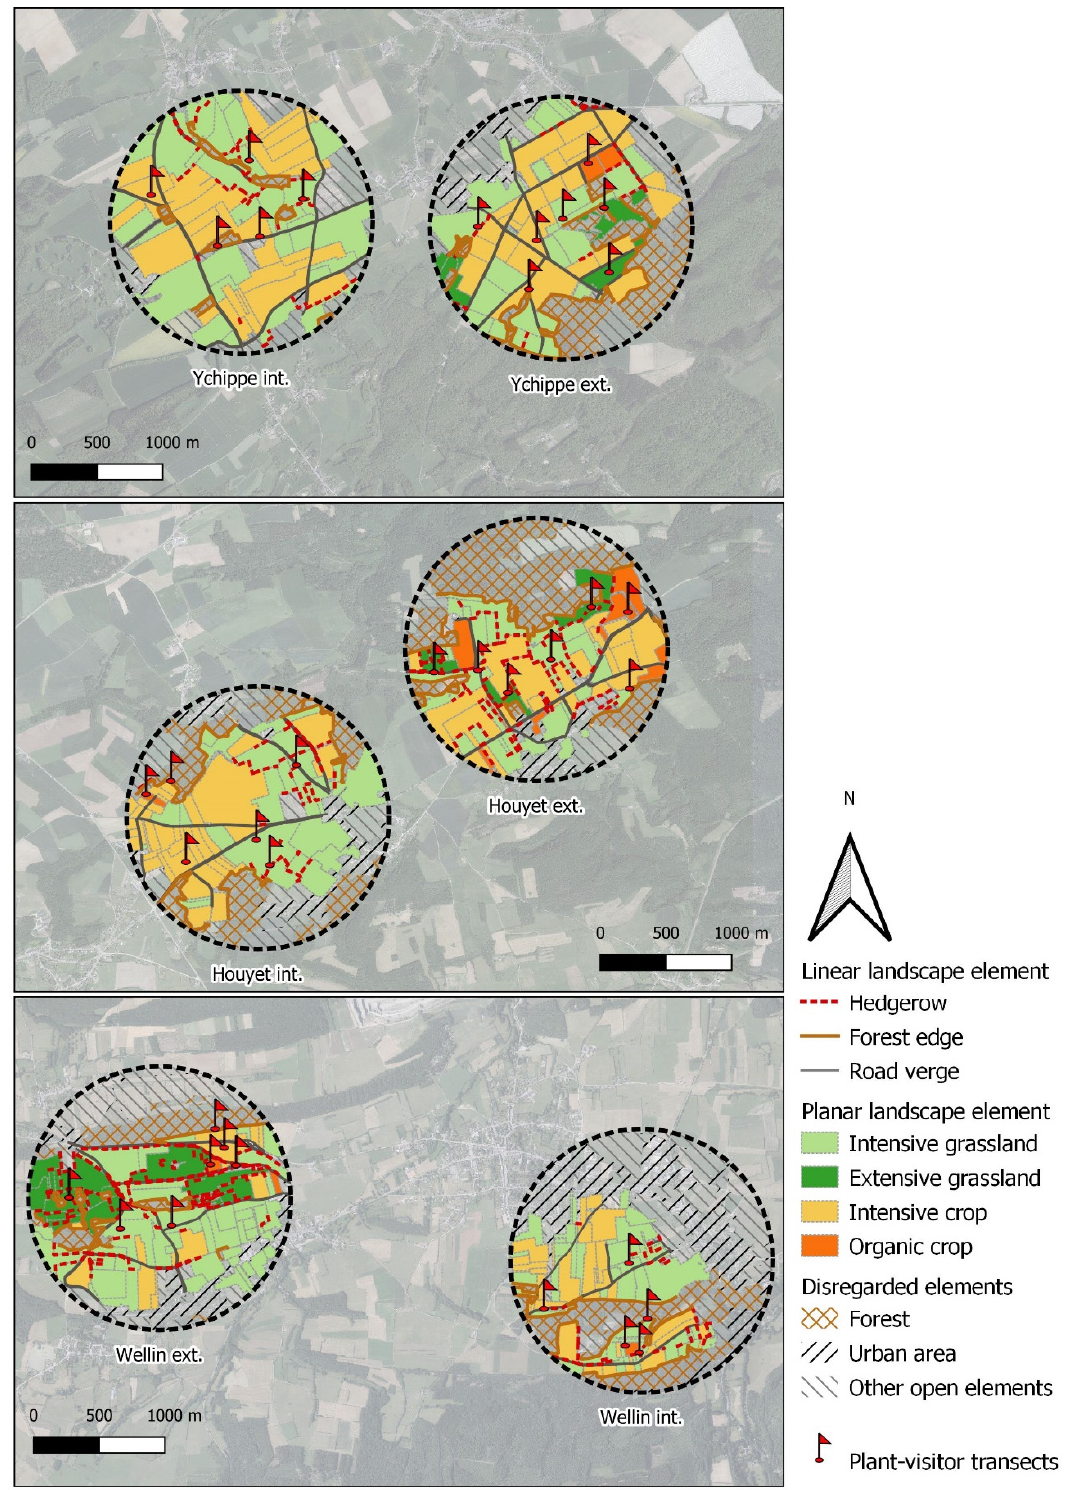
Figure 1. Location of the six studied agricultural landscapes. Hatched areas include not surveyed urbanized areas (including gardens and orchards), forests and other open elements. Locations of plant-visitor observation transects are indicated by red flags.